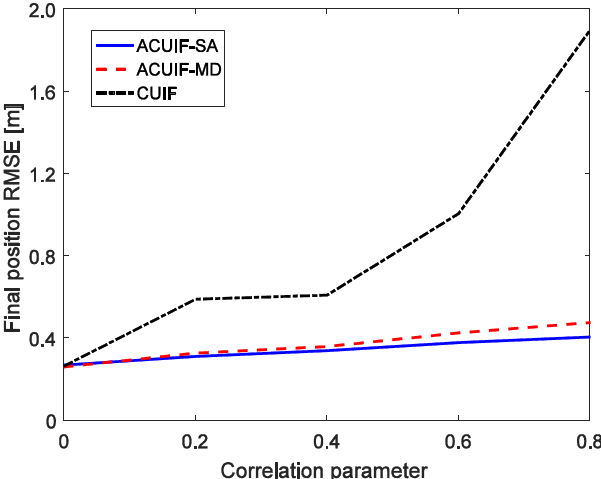
Figure 2. The final position RMSE for the three methods under different colored noises. Figure 3. The final position RMSE for the three methods under di ff erent colored